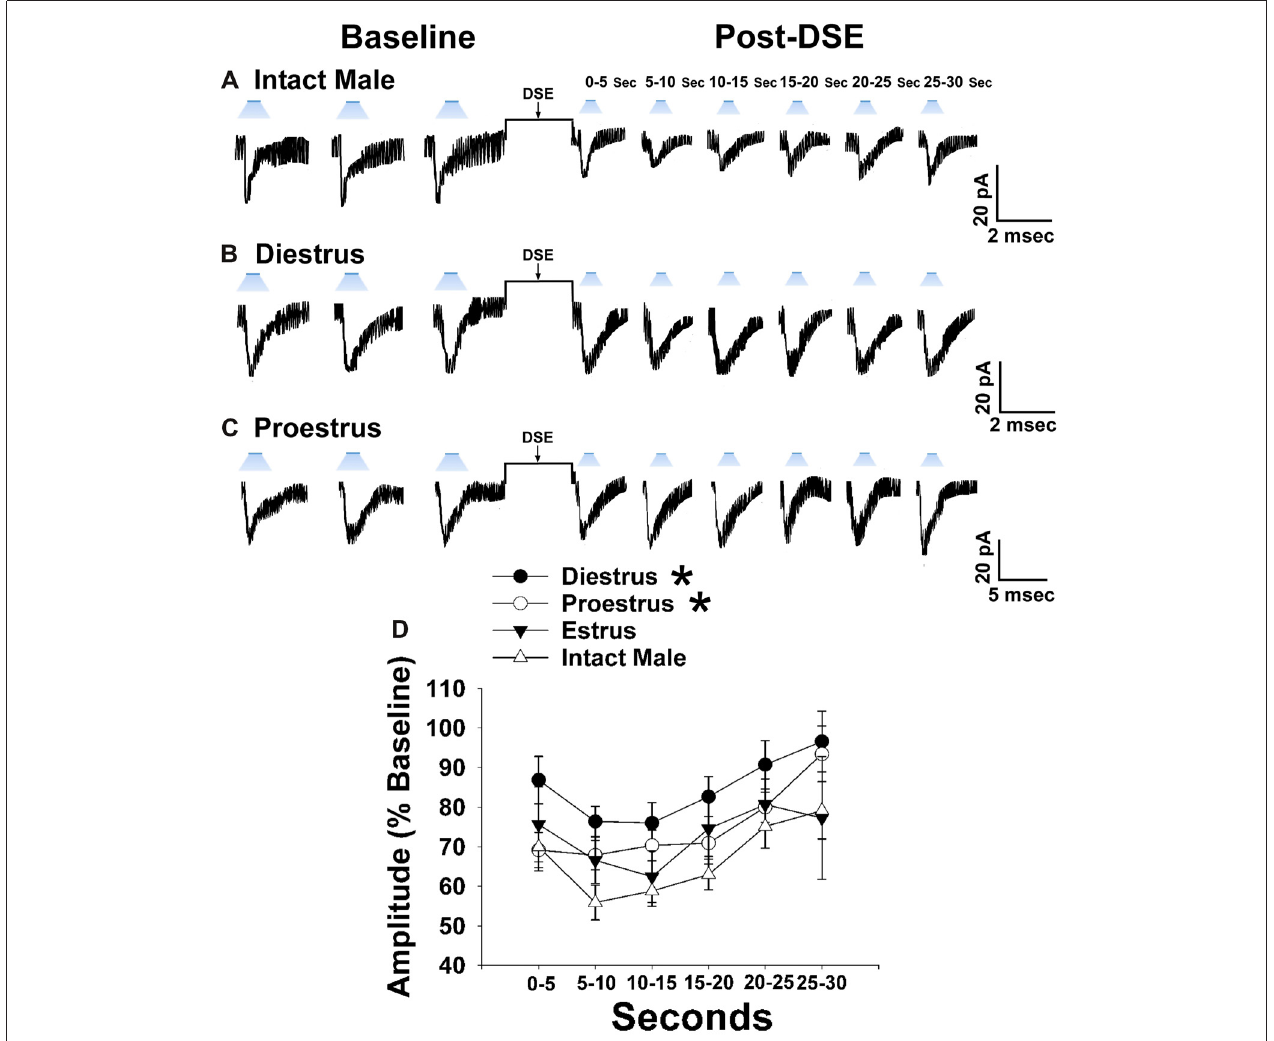
FIGURE 7 | Sex differences in the retrograde inhibition of glutamatergic input at VMN SF-1/ARC POMC synapses in NR5A1-Cre mice. The representative traces of membrane current show that the reduction in leEPSC amplitude caused by postsynaptic depolarization is comparatively larger in gonadally intact males ( A ; n = 22) than in diestrus ( B ; n = 19) and proestrus ( C ; n = 21) females. This can also be seen from the composite line graph (D) . Lines represent means and lines 1 SEM. ∗ P < 0.05; rank-transformed multifactorial